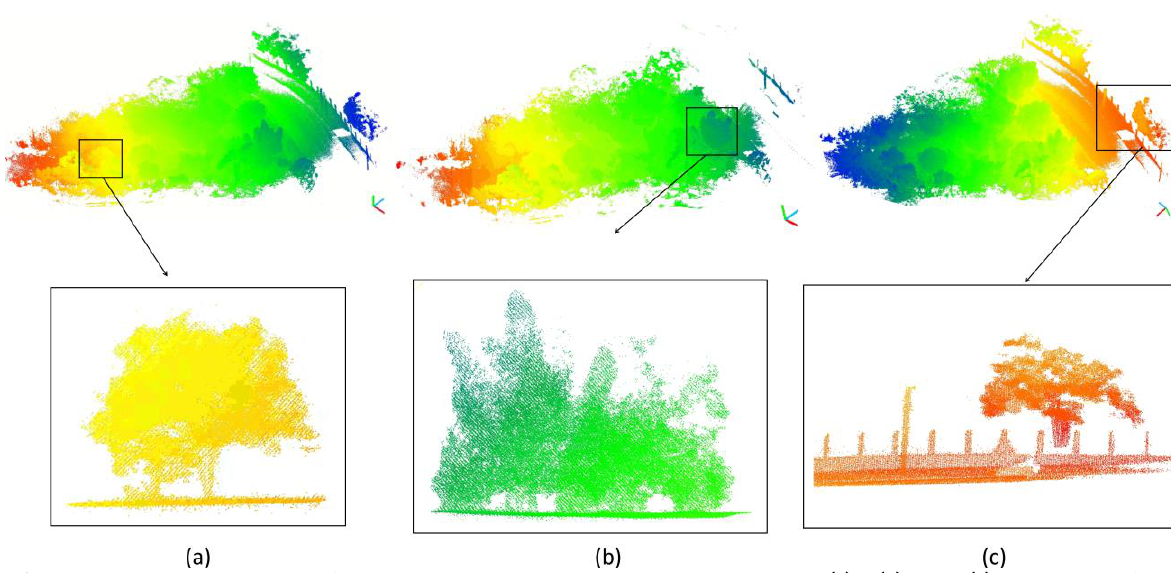
Figure 8. Point clouds, in a local reference system, generated in Web SLAM with data set (a) I, (b) II and (c) III. The scalar fields represent the coordinate h. In (a) and (b), the scalar field is different from (c) because the beginning of the trajectories for datasets I and II was the same, while dataset III was in opposite